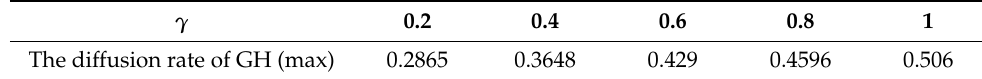
Table 5. The diffusion rate of GH at different γ